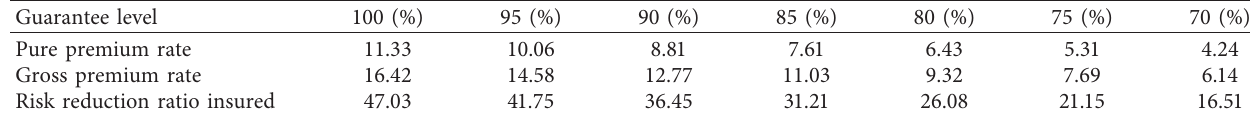
Table 4: Premium rate and risk of jujube revenue insurance in Aksu